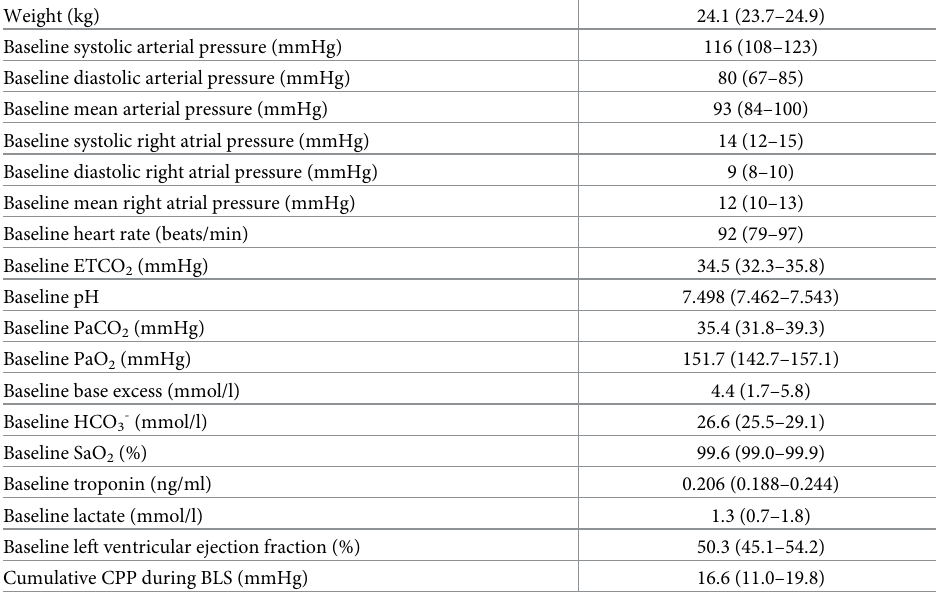
Table 1. Pre-arrest baseline measurements and coronary perfusion pressure during basic life